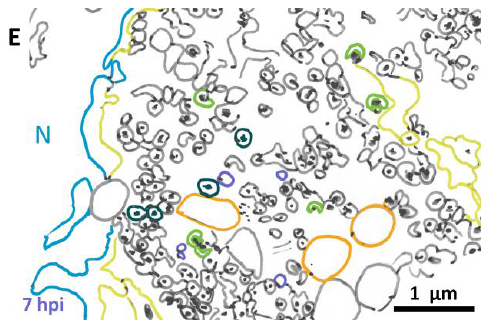
Figure 1. Changes in cellular morphology after poliovirus infection. Schematized cells from electron micrographs in Schlegel et al. , ( A , D ) [54], Dales et al. , ( B , E ) [53], and Mattern and Daniels ( C ) [57]. Representative structures are marked: nuclear membrane (blue), mitochondria (red), vacuoles (orange). Lines denote cytoplasm, and dots represent “viroplasm”. Endoplasmic reticulum (yellow) becomes enlarged and sometimes called “nuclear extrusions” (as in panel C ). Early in infection single membrane vesicles (purple) are visible, and later the appearance of U bodies/horseshoe-shaped vesicles (green) and double membrane vesicles (teal). In panel C , an image of a fractionated rosette (from Figure 3) is shown to scale, highlighting its similarity to structures seen within infected